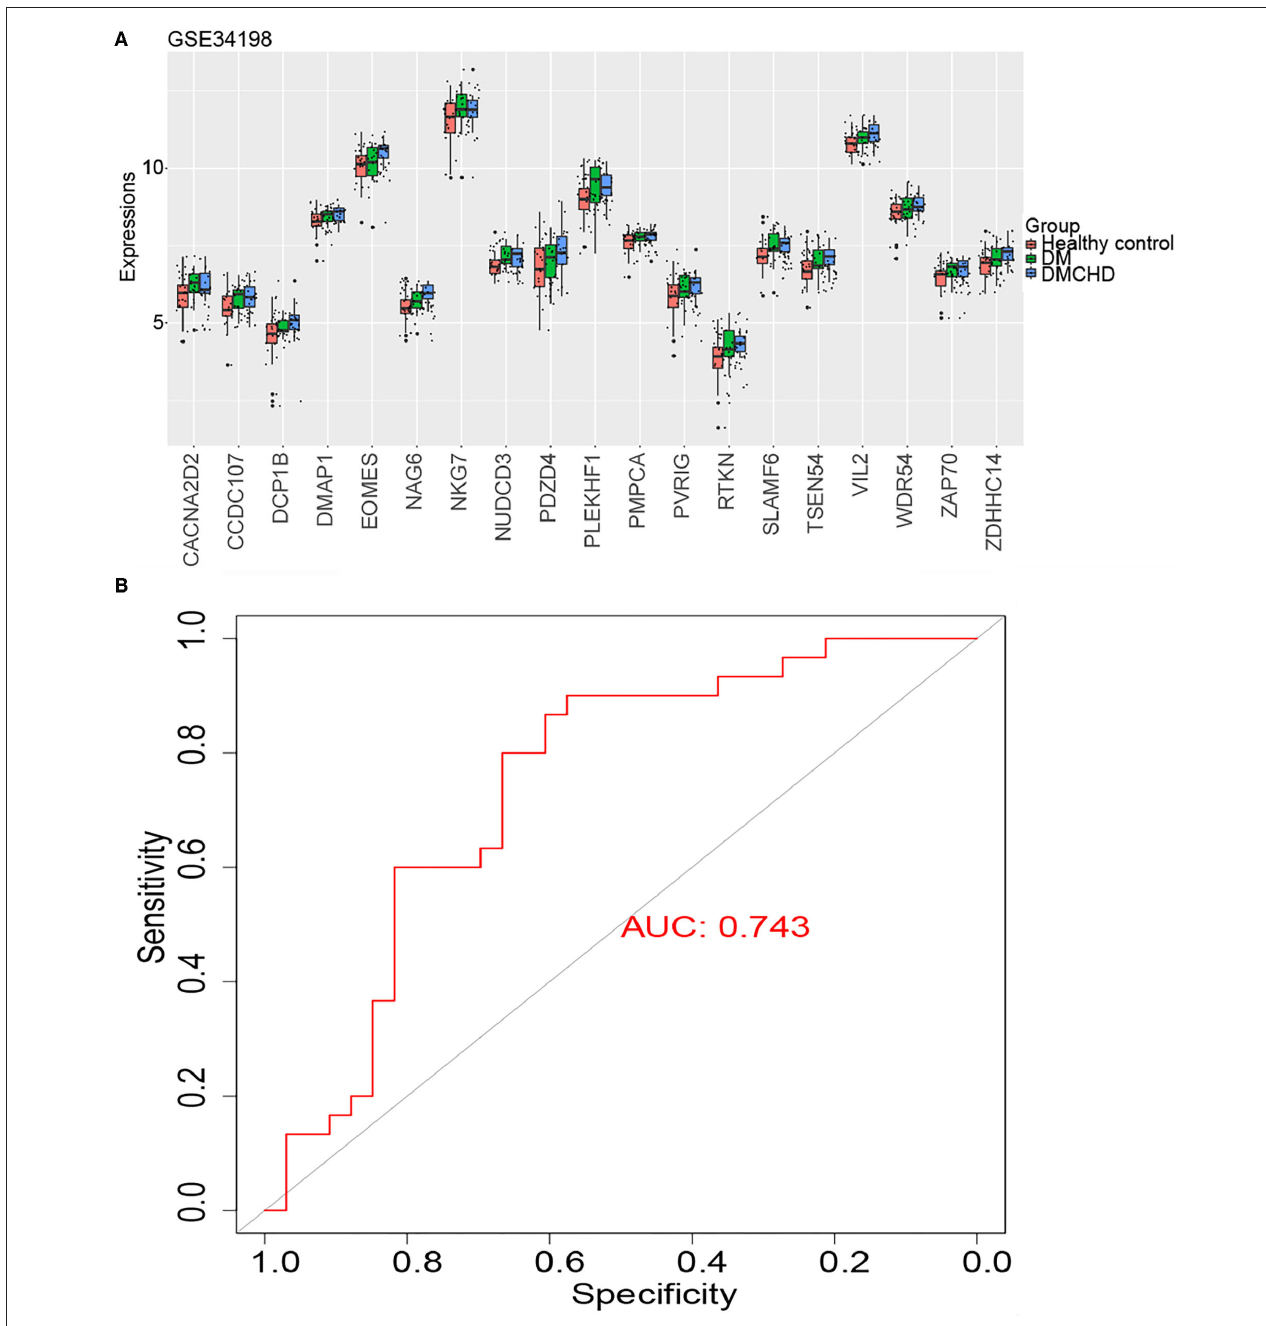
FIGURE 4 | Expression of diabetes mellitus-related atherogenesis genes (DRAGs) and their ability to predict diabetes mellitus-associated coronary heart disease (DMCHD). (A) The expression level of 19 DRAGs (genes with significance (GS) > 0.2 and module membership (MM) > 0.7 were considered as DRAGs) in tissue from healthy individuals and from patients with diabetes mellitus (DM) or DMCHD. (B) Receiver operating characteristic curve analysis of DM-related atherogenesis GSVA score for predicting